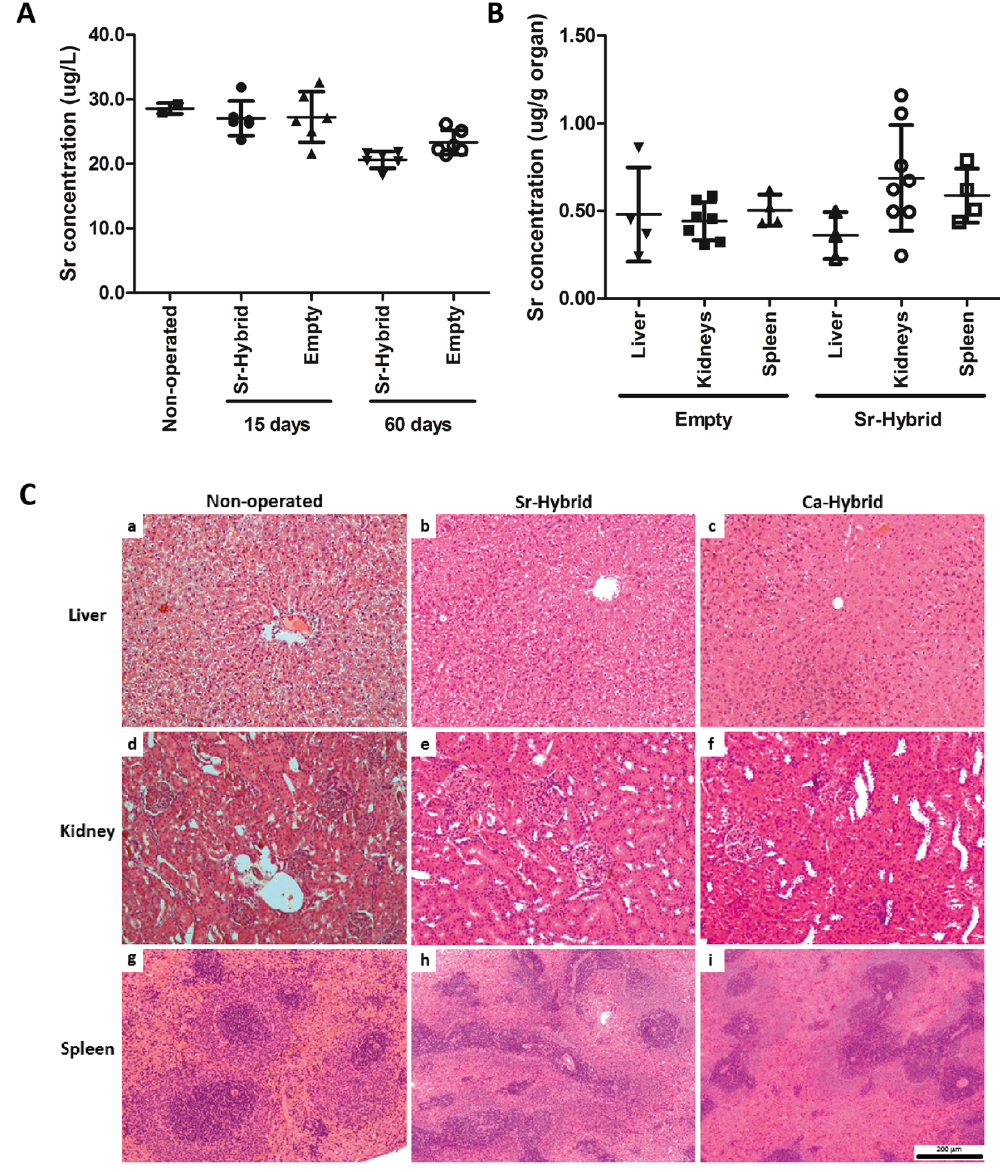
Figure 7. Strontium systemic evaluation. Sr concentration found in serum in non-operated, empty and Sr- hybrid implanted animals at days 15 and 60 post-surgery ( A ). Data presented as mean ± SD of 6 samples/group/ time point and 2 samples non-operated. Sr concentration found in the liver, kidneys and spleen of animals implanted with Sr-hybrid and empty defect, 60 days post-surgery ( B ). Data presented as mean ± SD of 4 samples/group/time point. Representative histological sections from liver (a to c), kidney (d to f) and spleen (g to i) of non-operated (a, d and g), Sr-hybrid (b, e and h) and Ca-hybrid implanted (c, f, and i) animals, 60 days post-surgery